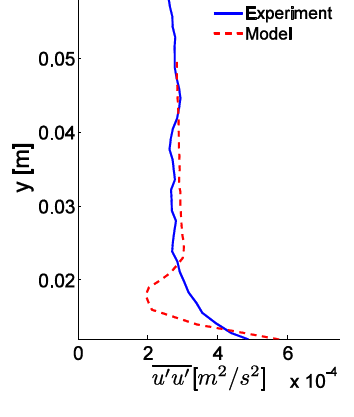
Table 1. Mean statistics for the simulated flow at inlet flow speeds of U respectively. U is the inlet velocity along the upstream end of the flow o